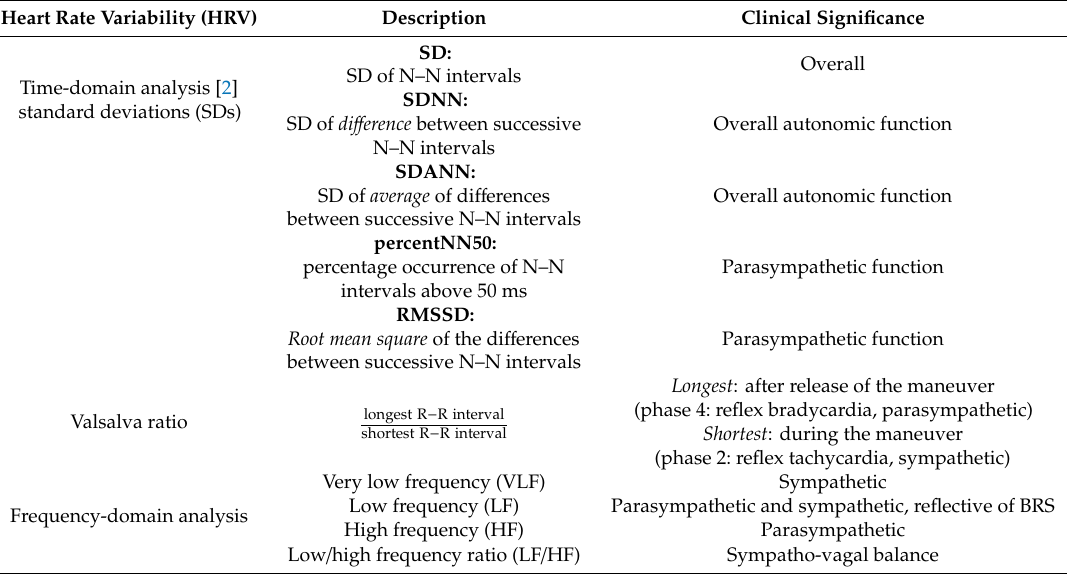
Table 2. Heart rate variability parameters. BRS, baroreceptor / reflex